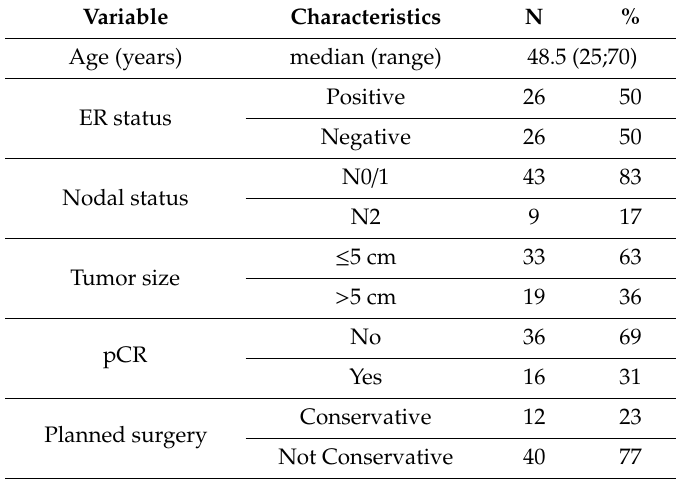
Table 1. Clinico-pathological characteristics of study